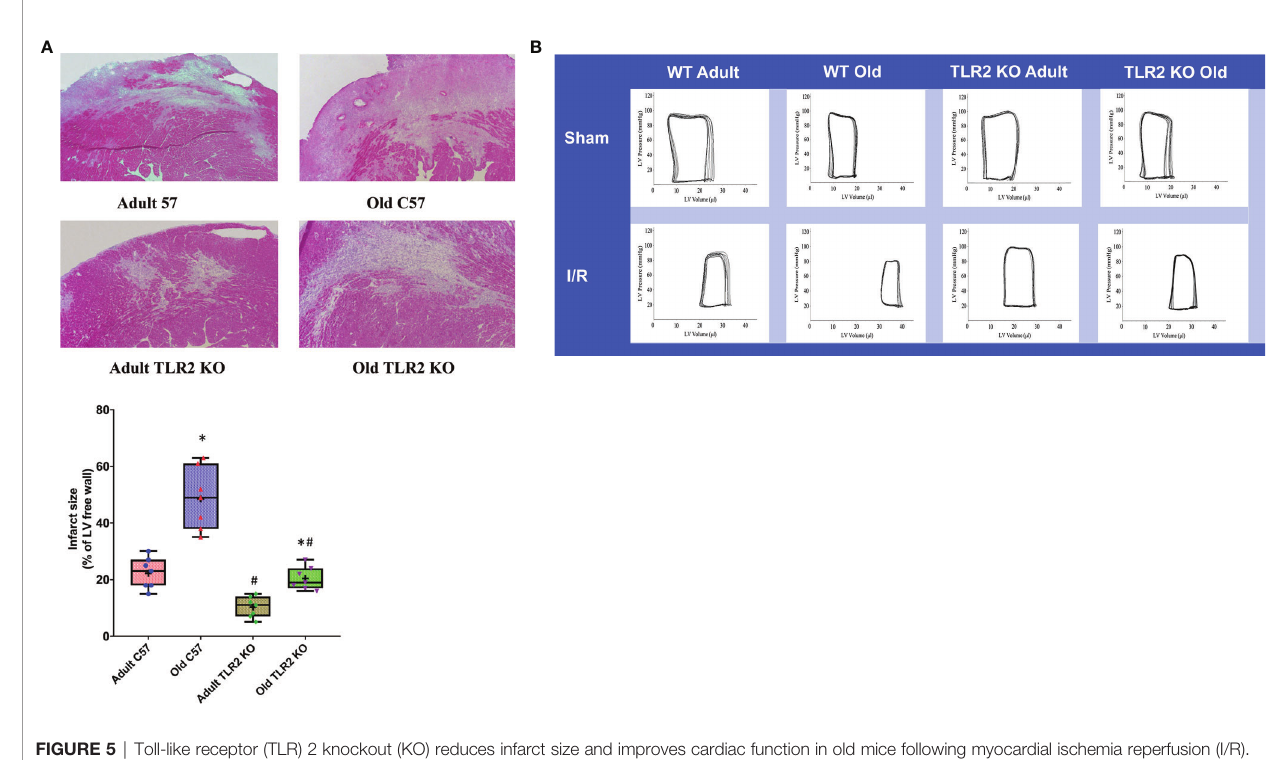
FIGURE 5 | Toll-like receptor (TLR) 2 knockout (KO) reduces infarct size and improves cardiac function in old mice following myocardial ischemia reperfusion (I/R). (A) Left ventricle free wall and myocardial infarct area were assessed under a microscope on tissue sections stained with hematoxylin and eosin. Infarct area was identi fi ed as the area with myocytes missing. Infarct size is expressed as a percentage of left ventricle free wall. Representative images and quantitative data show that TLR2 KO reduced infarct size in both adult and old mice at day 14 after I/R, but with a greater reduction in old mice. Data are presented as box-and-whiskers plots; the upper and lower borders of the box represent the upper and lower quartiles; the upper and lower whiskers represent the maximum and minimum values of nonoutliers; the horizontal line in the box represents the median, and the + sign represents the mean. N = 7 in each group, * P < 0.05 vs. adult mice of the same strain. # P < 0.05 vs. C57BL/6 wile-type mice of the same age. (B) left ventricular function was analyzed by a microcatheter at day 14 after I/R. Representative pressure-volume loops show that old TLR2 KO mice have markedly improved left ventricle functional performance compared to old wild type